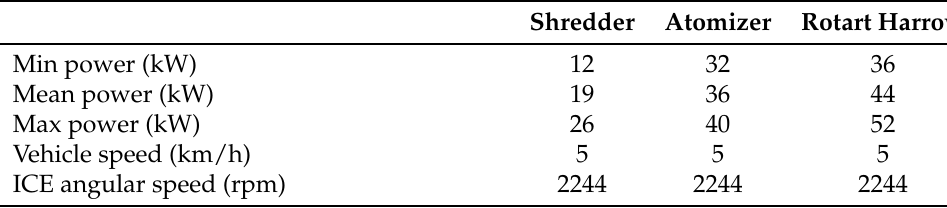
Figure 3. Typical agricultural gearbox configuration for maximal travel speed coverage. Table 2. Relevant characteristics of proposed implement-related activities